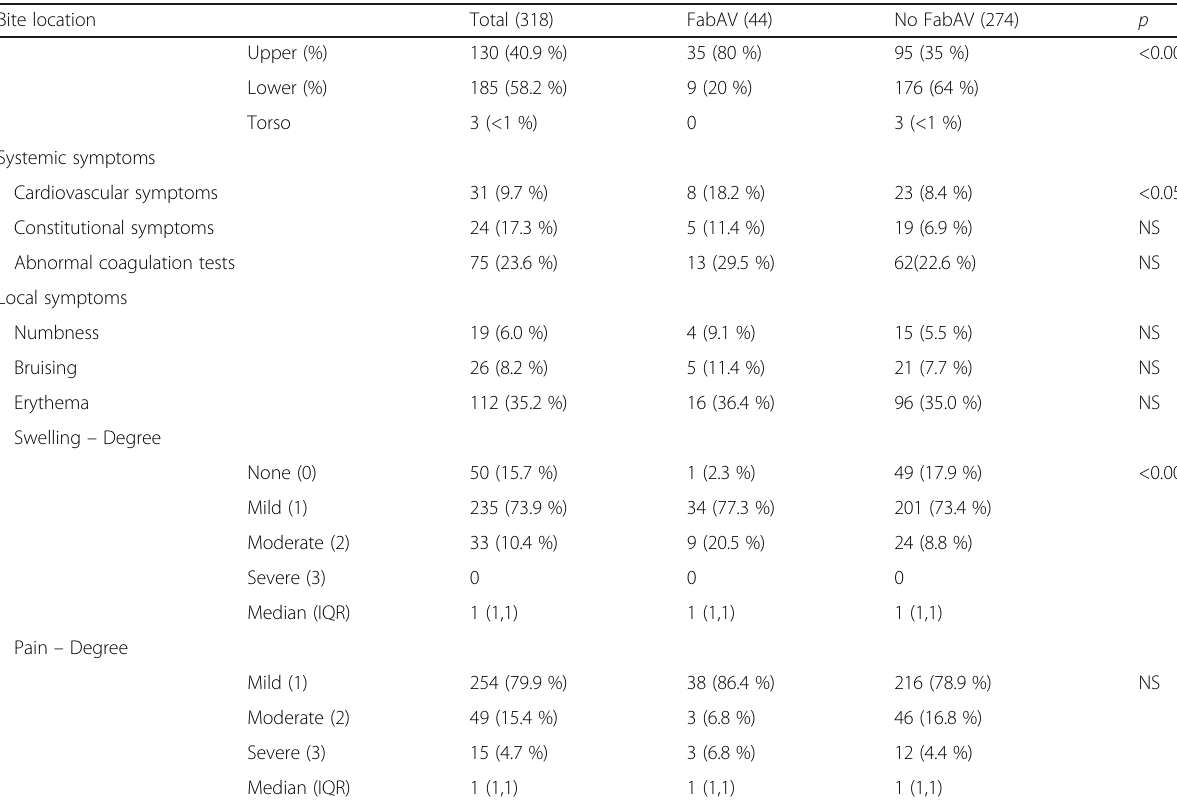
Table 2 Clinical